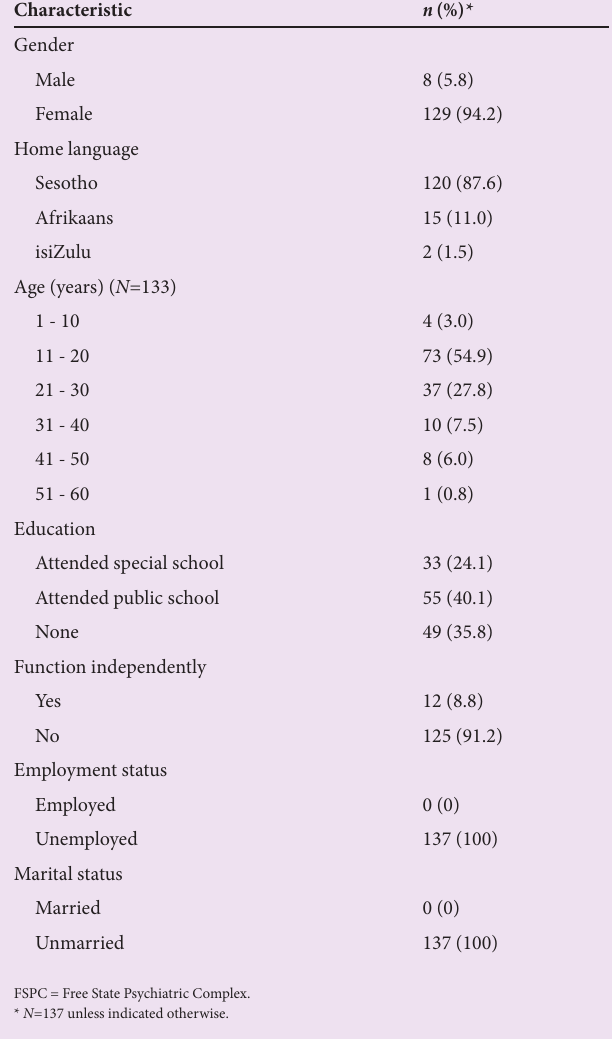
Table 1. Sociodemographic characteristics of mentally retarded rape victims evaluated at the FSPC, 2003 - 2009